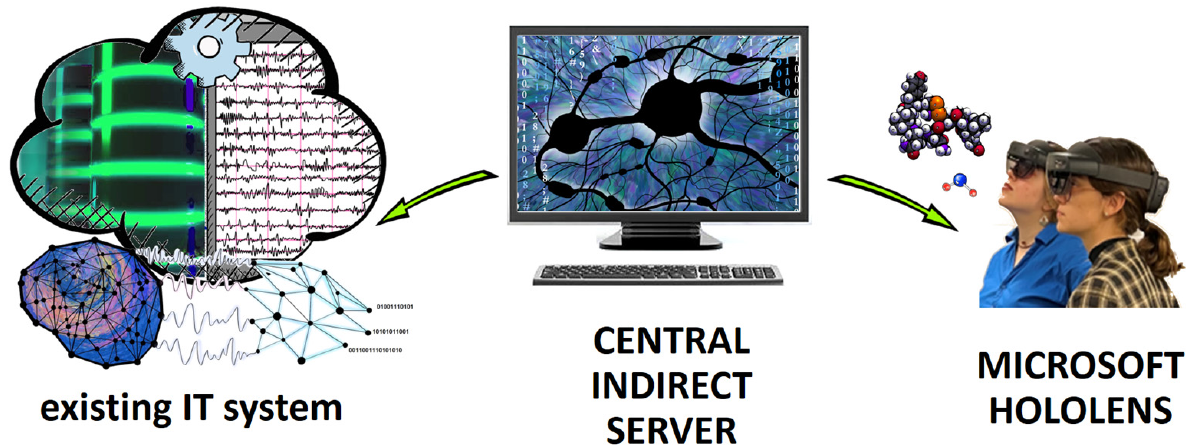
Figure 1. System design, for use in remote and in-person medical education, particularly chemistry.